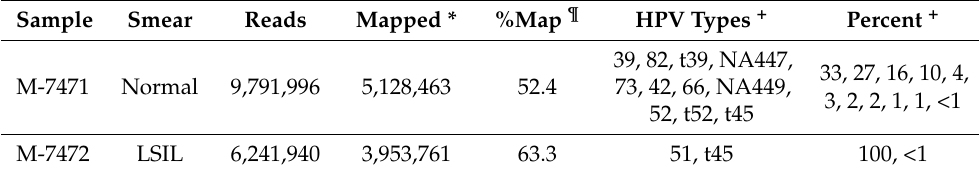
Table 1. Cont. Sample